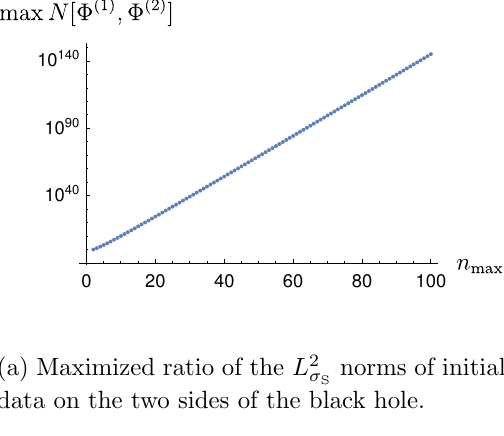
(a) Maximized ratio of the L 2 data on the two sides of the black hole.